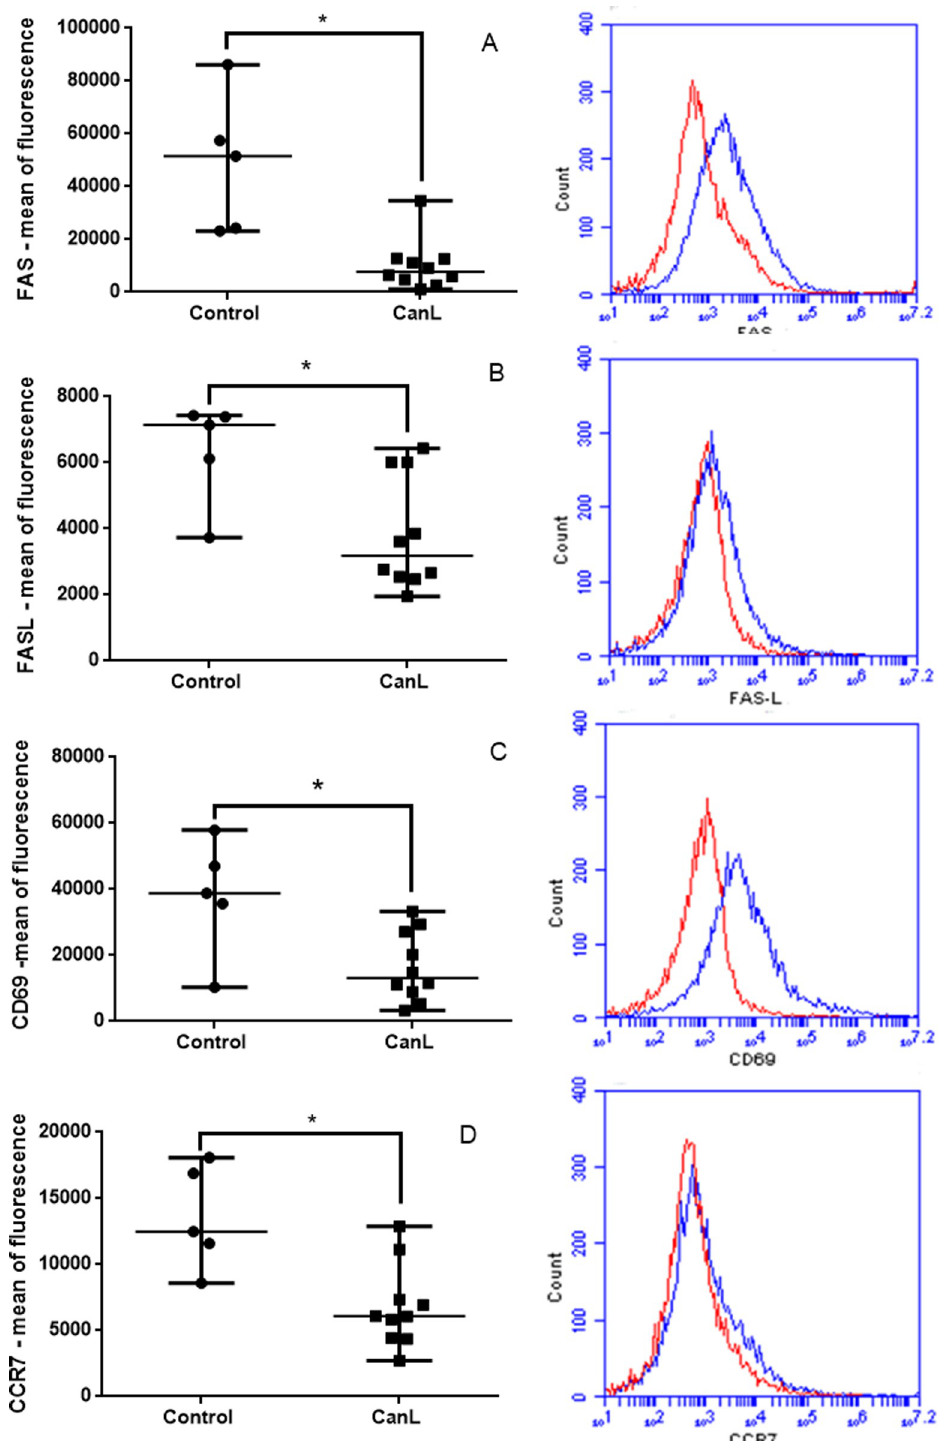
Fig 2. Expression of proteins regulated by miR-21 in splenic leukocytes of CanL and healthy dogs. Expression of FAS (A), FASL (B), CD69 (C), and CCR7 (D) in splenic leukocytes from CanL and healthy dogs after culture and respective representative histograms obtained from flow cytometry analysis. The red line represents the CanL group, and the blue line represents the control group. Cells were cultured for 48 h at 37˚C and 5% CO 2 without treatment (medium) and then incubated with monoclonal antibodies. Data are presented as median ± min-max. Asterisks represent statistical significance (Mann–Whitney, � p < 0.05). https://doi.org/10.1371/journal.pone.0265192.g002 PLOS ONE | https://doi.org/10.1371/journal.pone.0265192 March 24,